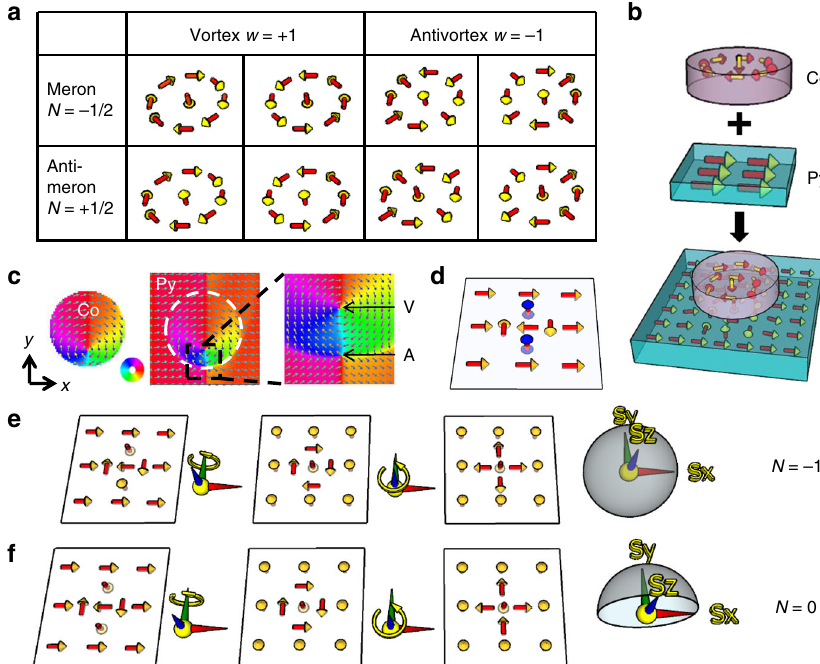
Fig. 1 Meron pair and topology. a De fi nition and corresponding relation between vortice/antivortice and meron/antimeron, where w denotes the winding number and N denotes the topological number ( N = pw /2 with p = + 1 for up and p = − 1 for down polarity of the cores). It is worth to mention that winding number is always + 1 for vortex and − 1 for antivortex, and does not depend on the clockwise or counterclockwise circulation direction of the in-plane magnetization 35 . b Schematic drawing of vortex imprinting from a Co disk into a continuous Py fi lm. c Simulation result of the magnetization distribution in a system with a Co disk (40 nm thick and 1 μ m radius) on top of a 80 nm thick Py fi lm. The result clearly shows the imprinting of the vortex from Co into Py, as well as a spontaneous creation of an antivortex to pair with the imprinted vortex. The positions of the vortex and antivortex in the Py fi lm are highlighted by “ V ” and “ A ” in the zoomed in magnetization pro fi le. The color wheel is shown next to the Co pro fi le (each color on the wheel represents magnetization directing toward the corresponding radial direction outward.) d A simpli fi ed illustration of the magnetization pro fi le of the meron pair. e , f Topology of the meron pair depends on their core polarities. Under a continuous spin deformation, the bimeron state ( e ; N = − 1) is transformed into a skyrmion which wraps the full S 2 spin space. In contrast, the meron – antimeron pair ( f ; N = 0) is transformed into a state in which the y > 0 ( y < 0) half plane wraps (unwraps) the same half of the S 2 spin space, allowing a continuous shrinking of this semisphere to a single point on S 2 , i.e., a single domain state with N = 0. Note, there are totally four possible combinations of the core polarities. We only show two of them because the other two cases are just mirror re fl ection of the shown two